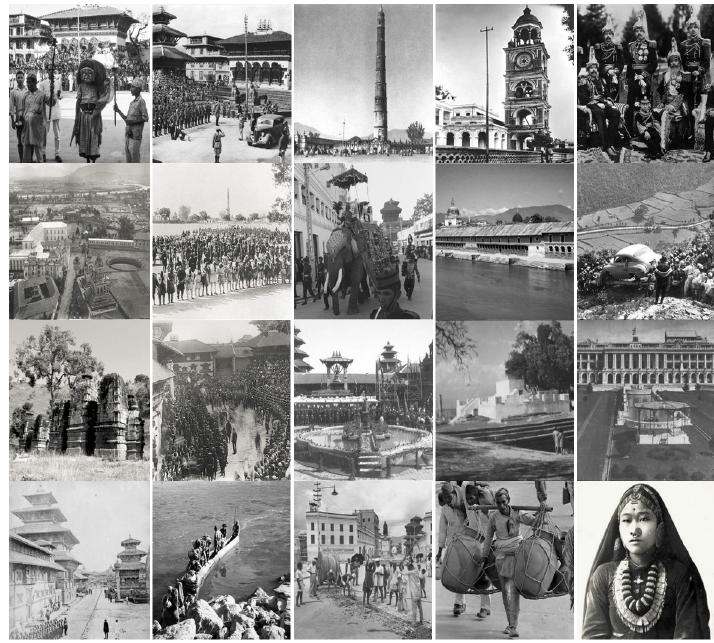
Figure 2. Some sample images from the test